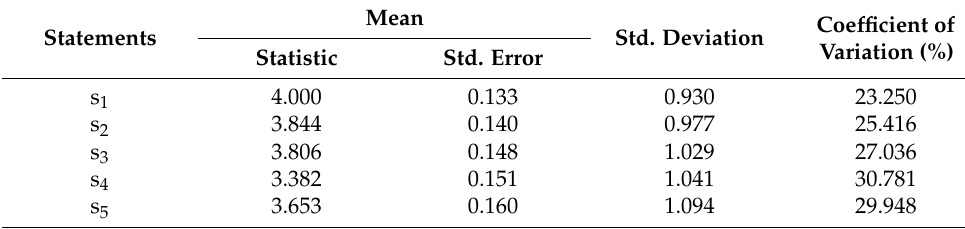
Table 8. Descriptive statistics for a group of